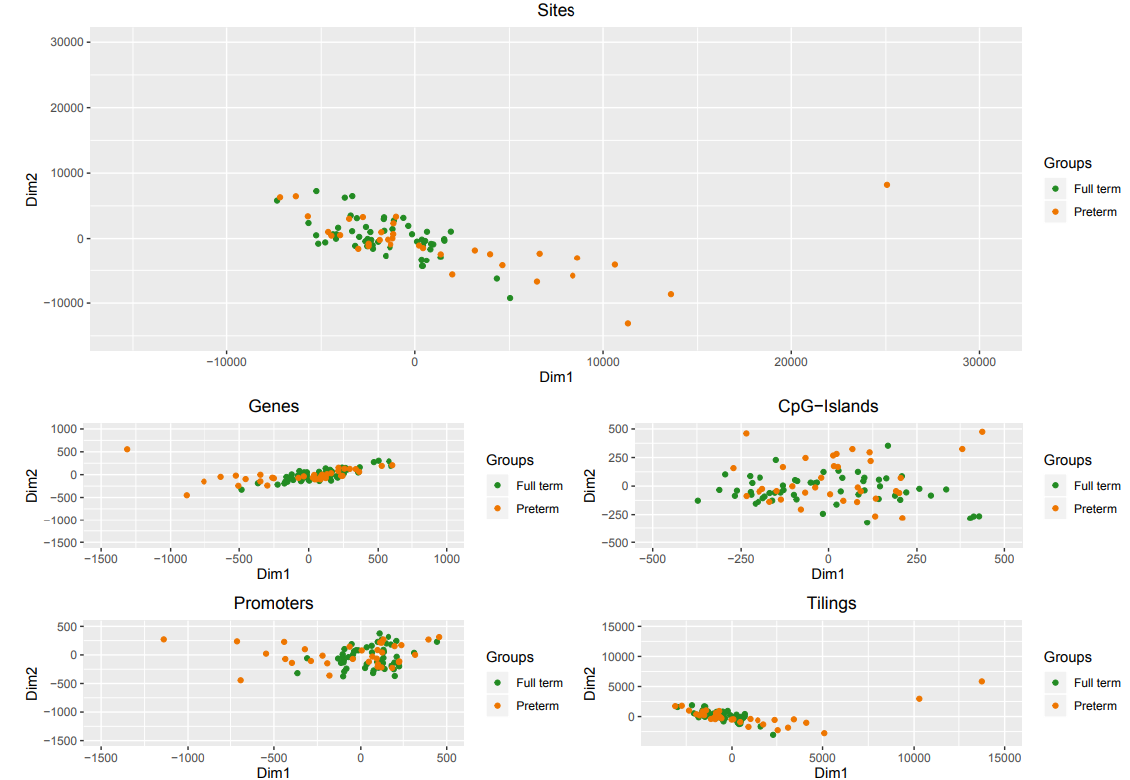
Figure 2. Dimensional reduction of methylation data. Scatter plot showing samples after performing Kruskal’s non-metric multidimensional scaling. Only the first two dimensions are shown.